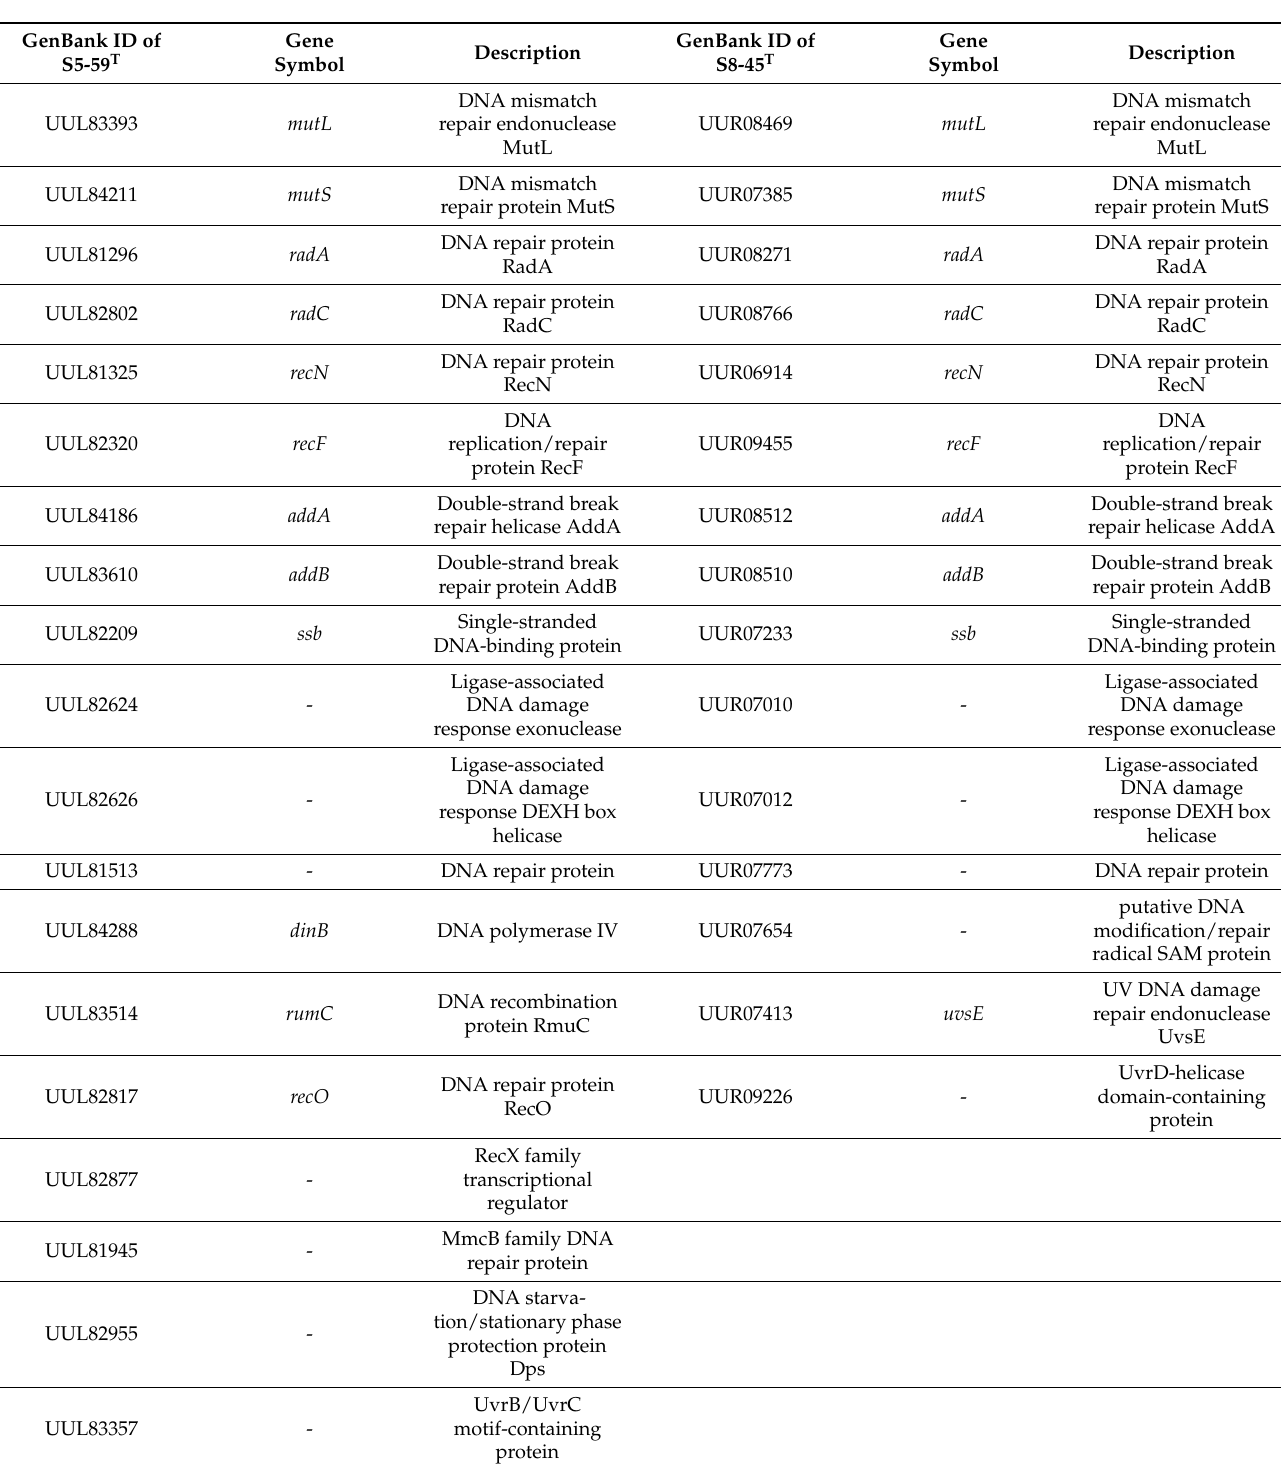
Table 2. List of genes encoding radiation-resistant DNA repair response proteins in the genomes of type strains S5-59 T and S8-45 T